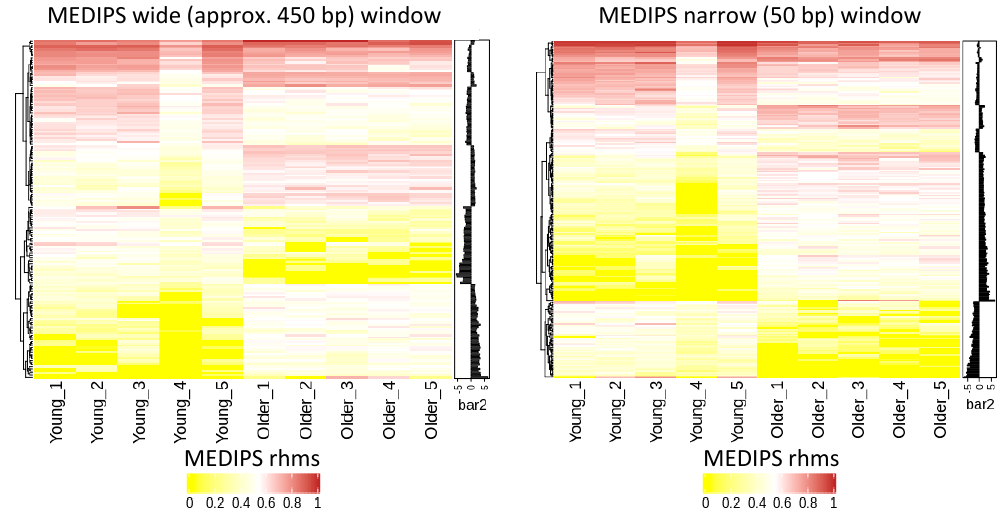
Figure 4. Heatmaps of age-associated differentially hydroxymethylated regions (DHMRs) in the DNA of human fibroblasts obtained from young ( n = 5, 22–35 years) and older ( n = 5, 74–94 years) individuals. The 5-hydroxymethylcytosine (5hmC) distribution was analyzed using hMeDIP-seq. RPKM: reads per kilobase million, rhms: relative hydroxymethylation